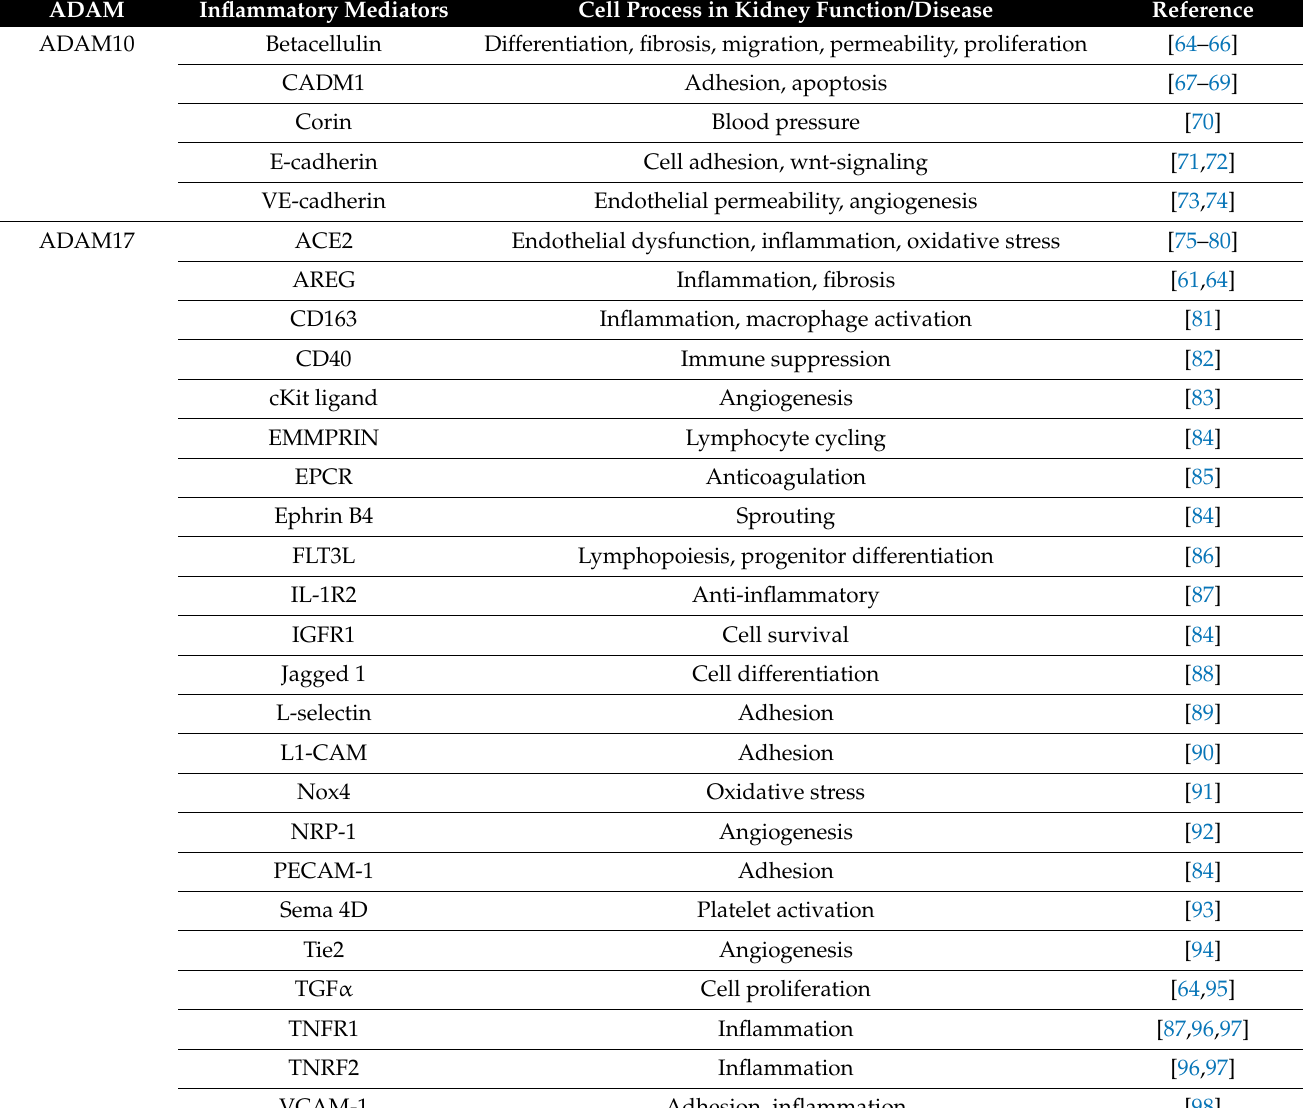
Table 2. List of ADAM10 and/or ADAM17 substrates with relevance for kidney disease and atherosclerosis